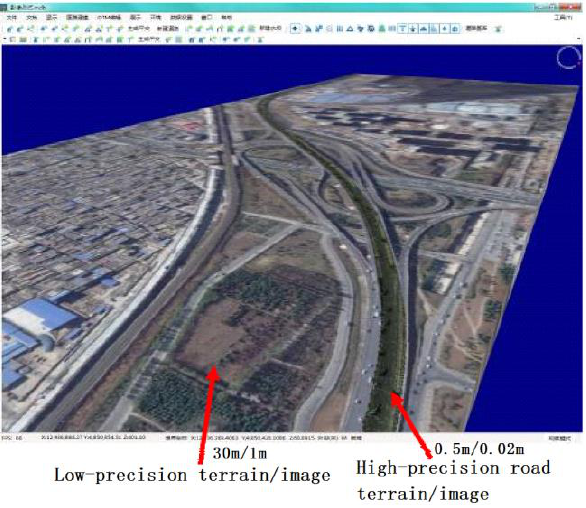
Figure 3 Schematic diagram of fusion and 3D application of high and low precision